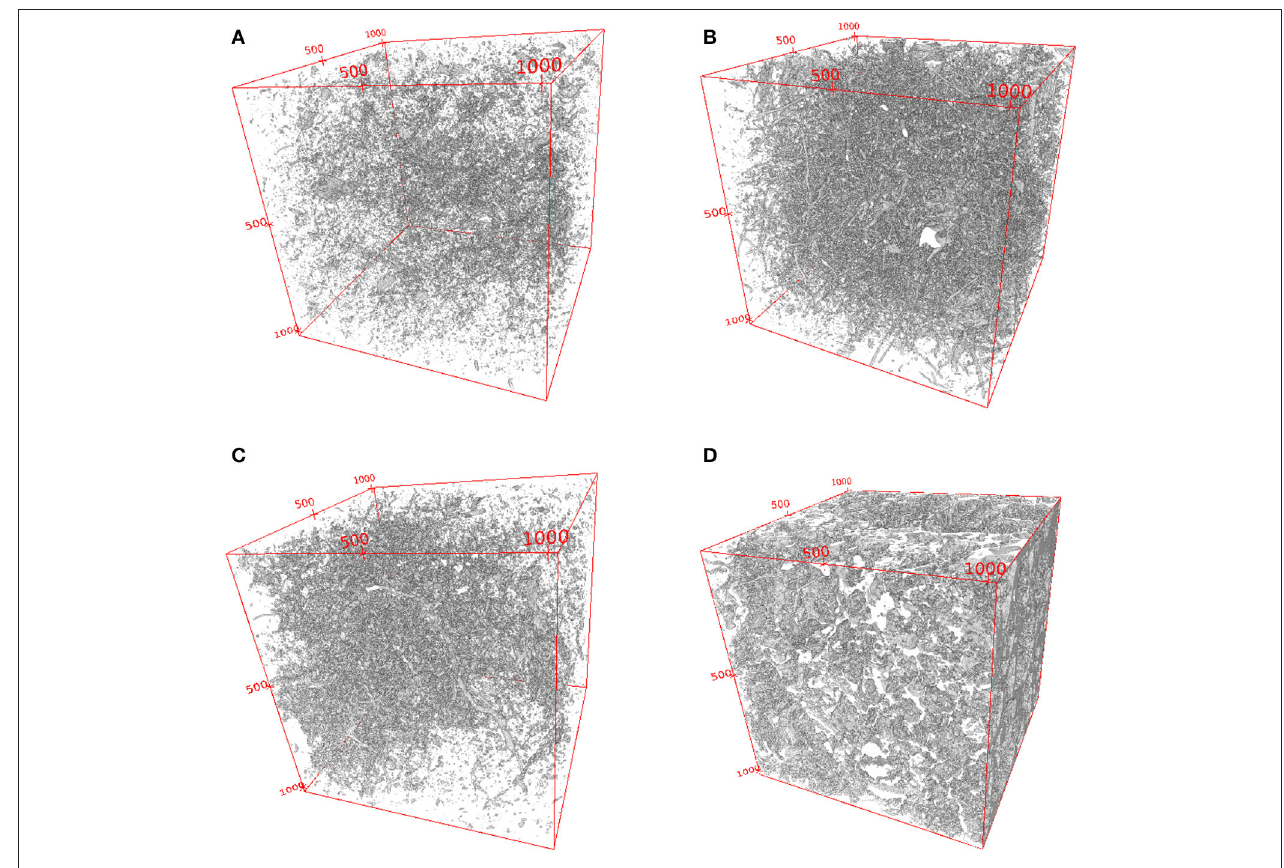
FIGURE 1 | Three-dimensional reconstruction pores space (black). Ticks in the axes correspond to pixel number. (A) Top soil sample cube from conventional tillage. (B) Bottom soil sample cube from conventional tillage. (C) Top soil sample cube from permanent cover crop of natural vegetation. (D) Bottom soil sample cube permanent cover crop of natural